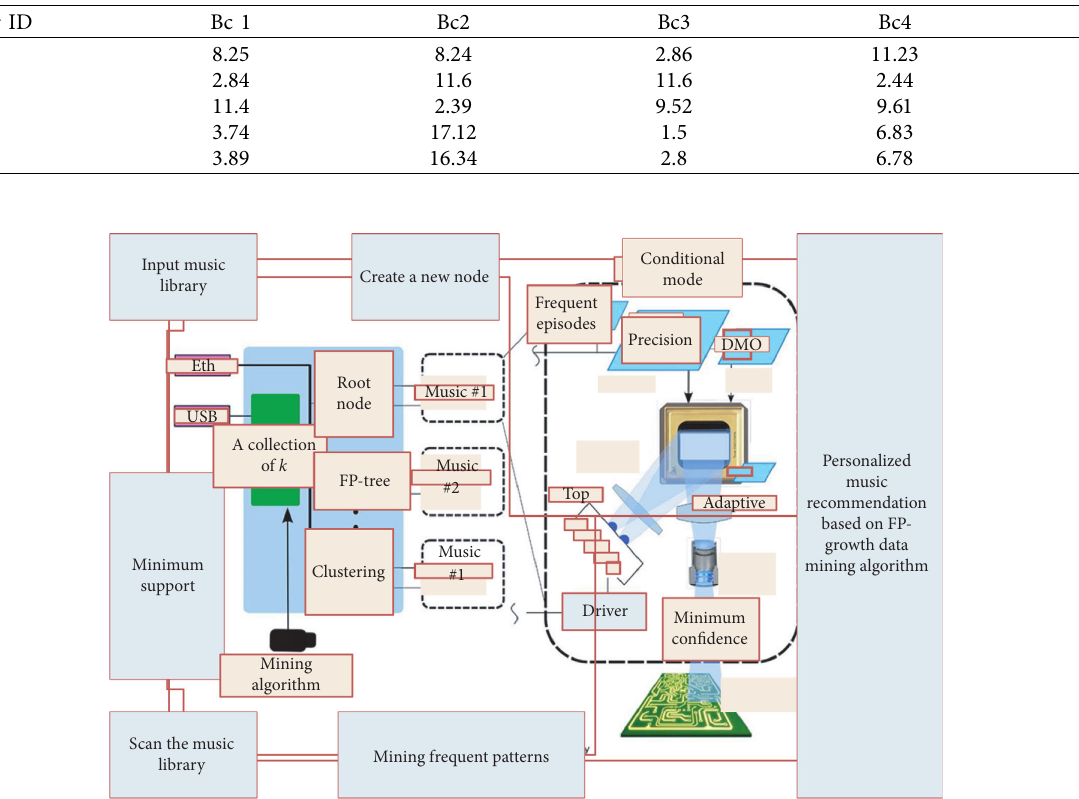
Figure 2: Flowchart of personalized music recommendation algorithm for FP data